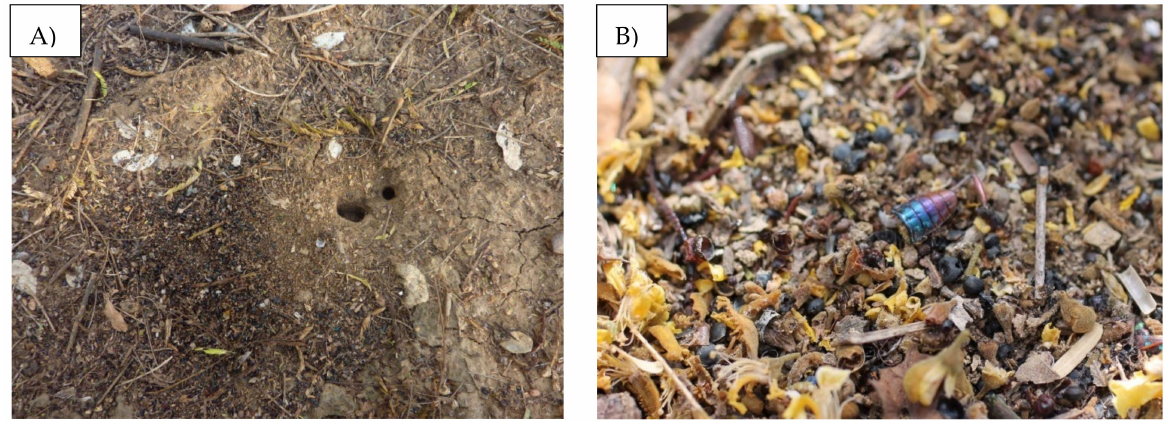
Figure 1. Photographs of ( A ) a P. fallax nest and ( B ) its refuse